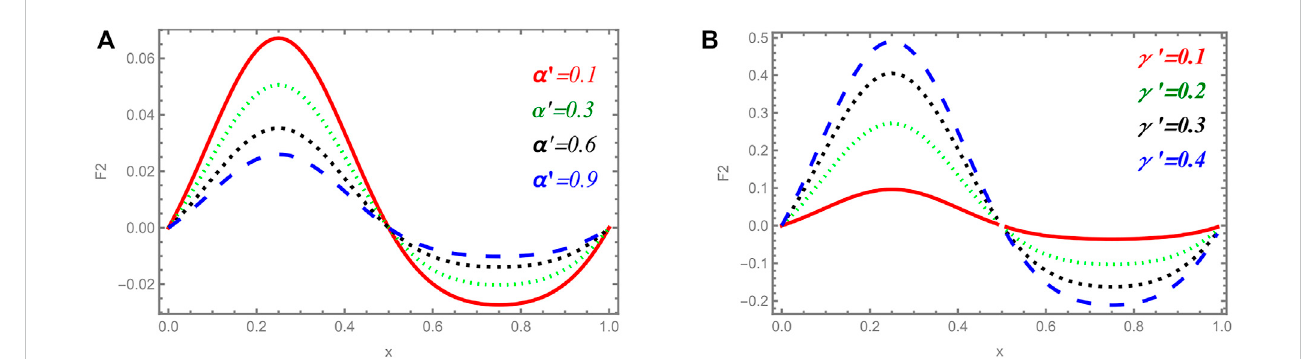
FIGURE 4 (A) represents the various values of α ′ on F 2 when M , C , γ ′ (cid:2) 0 . 1. (B) represents the various values of γ ′ on F 2 when M , C , (cid:2) 0 . 1 , α ′ (cid:2) 1 . 0.